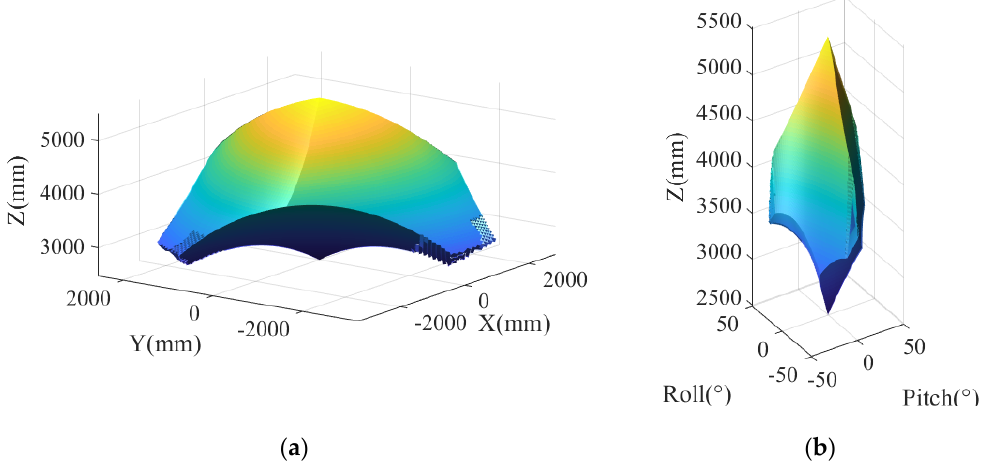
Figure 17. Position workspace and attitude workspace of the novel compensation platform. ( a ) is the position workspace of the new platform. ( b ) is the attitude workspace of the new platform.